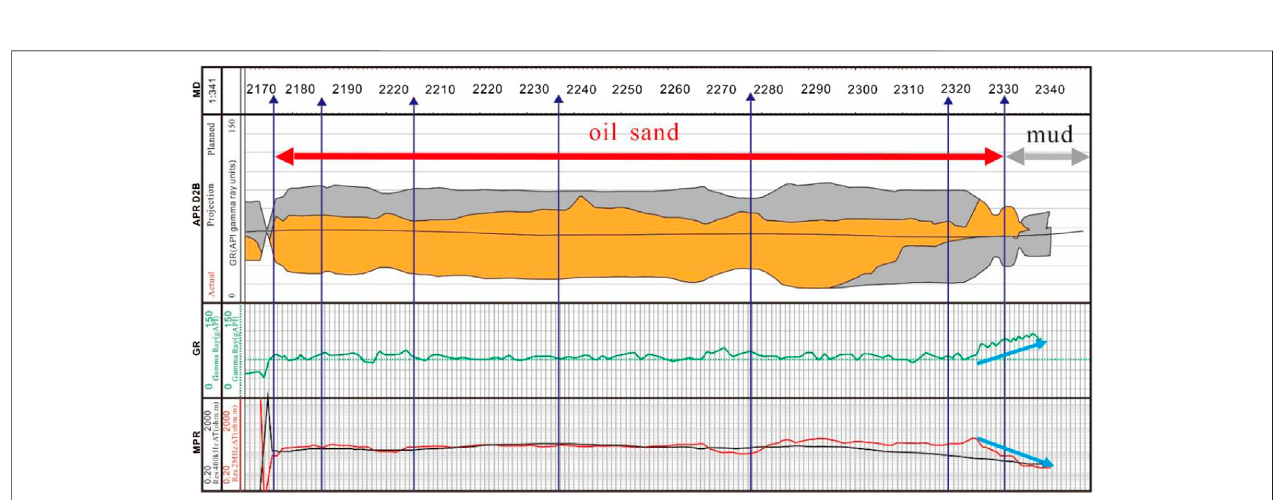
FIGURE 6 | LWD presentation of well 251 GB-P2 (Schlumberger company) shows that the sand body at the boundary of layer 42 meander-river belt in the Upper Guantao Formation presents a wedge shape with a fl at top and upturned bottom.